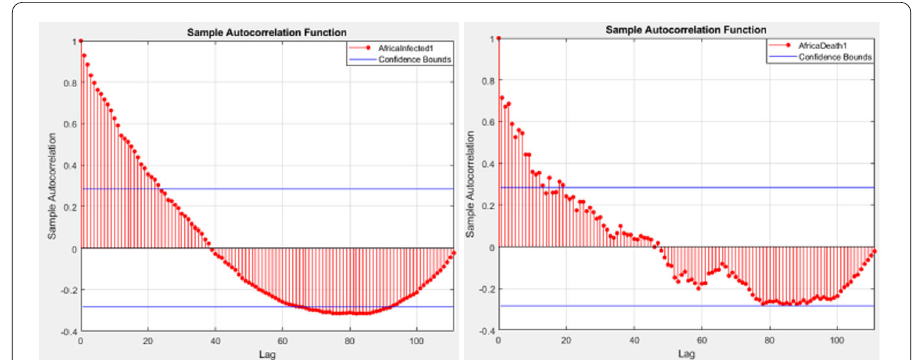
Figure 1 Autocorrelation function for the infected and deaths in Africa